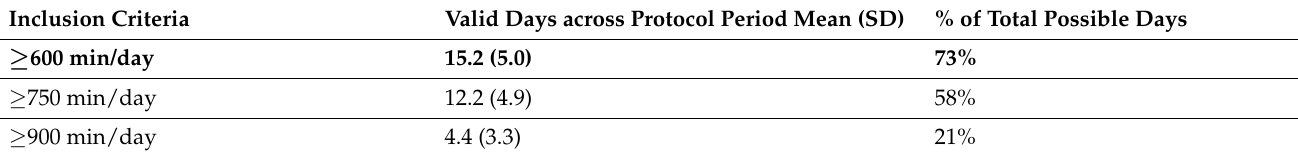
Table 5. Data inclusion based on daily wear time, per